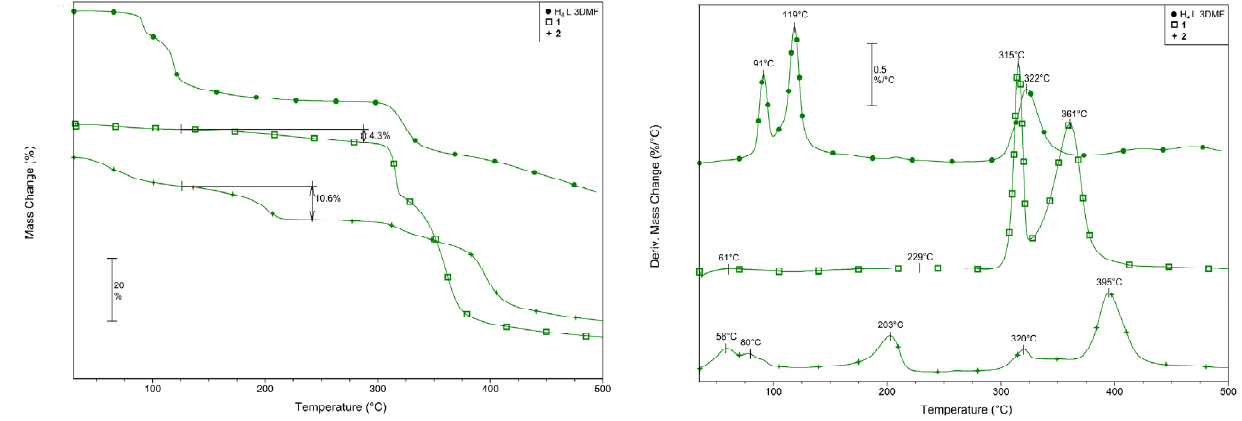
Figure 5. TG ( left ) and DTG ( right ) curves of the H 4 L, 1 and 2 recorded in argon.